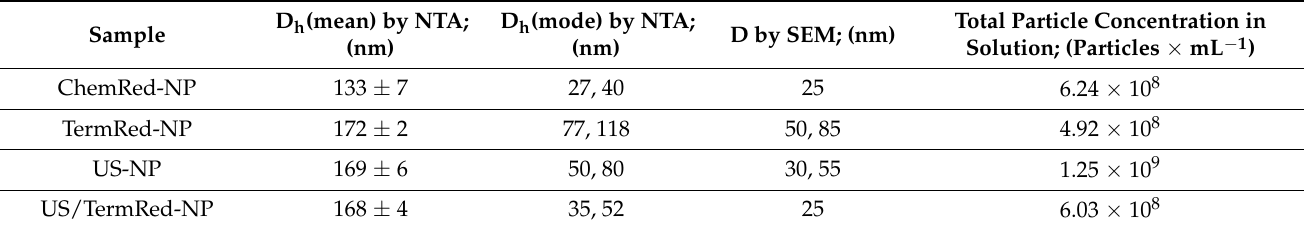
Table 1. Dependence of the size (Dh) of a particle of iron-based composite nanomaterials obtained by various methods, according to NTA, SEM data, and their concentration in a solution.